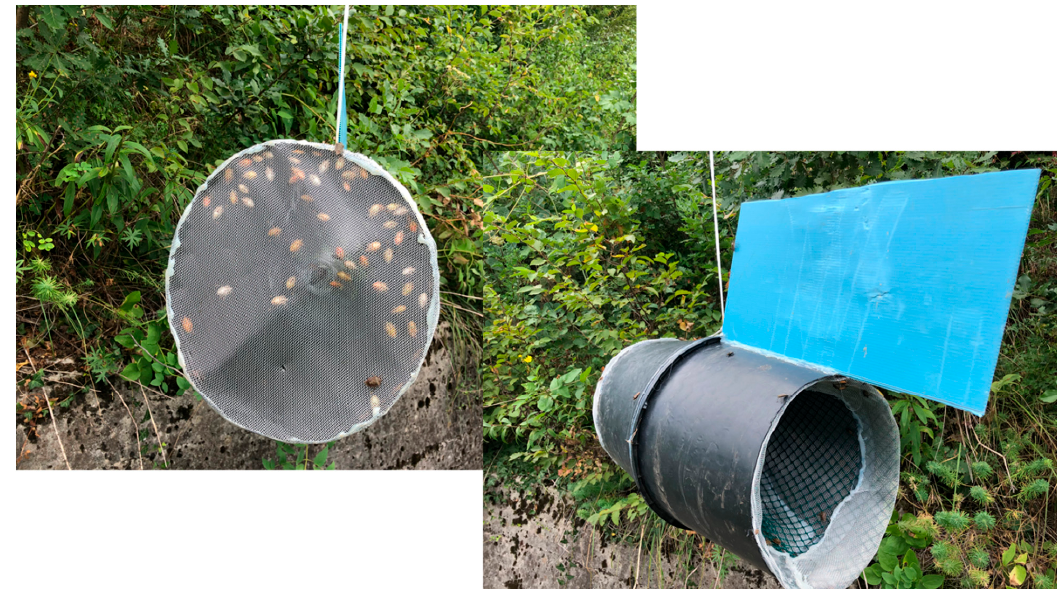
Figure 1. Rotating live trap for Halyomorpha halys consisting of two large black flower pots joined in the middle, with bases removed and a removable mesh cone for bug entry and removal, an upwind mesh panel for airflow, and an aggregation pheromone lure, with a wind vane to generate the best plume from the trap.